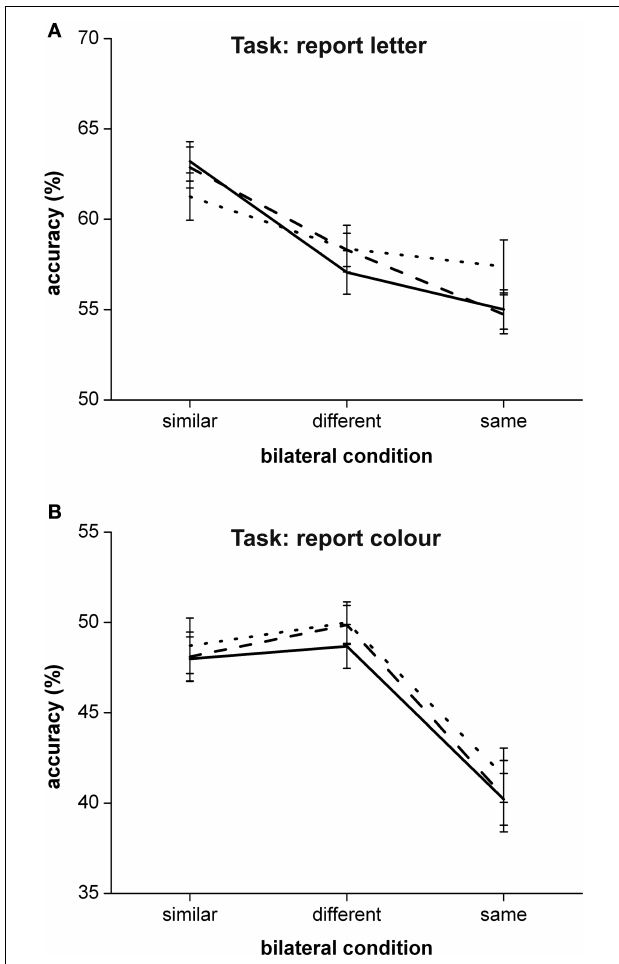
FIGURE 2 | The identifi cation performance accuracy for the low salience target stimuli over the different bilateral experimental conditions in the letter identifi cation task (A) and the colour identifi cation task (B). The relevant stimulus attribute condition is plotted along the x -axis. The different lines refl ect the different irrelevant stimulus attribute conditions; solid line = bilateral similar, striped line = bilateral different, dotted line = bilateral same. Error bars refl ect normalized standard error of the